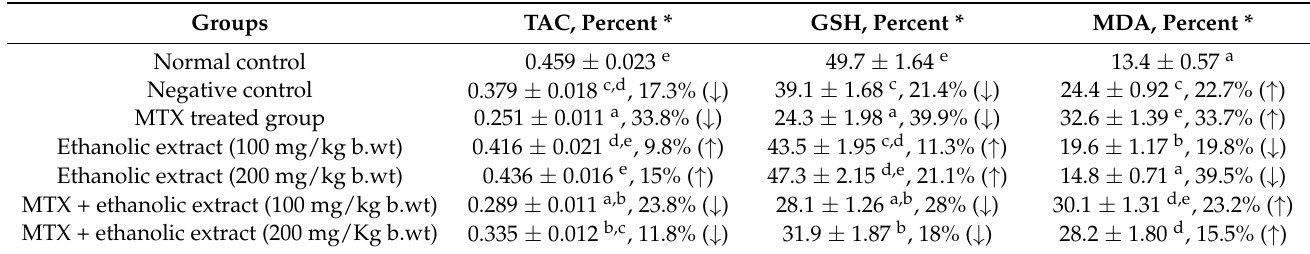
Table 3. Effect of different treatments on levels of markers of oxidative stress (TAC, GSH and